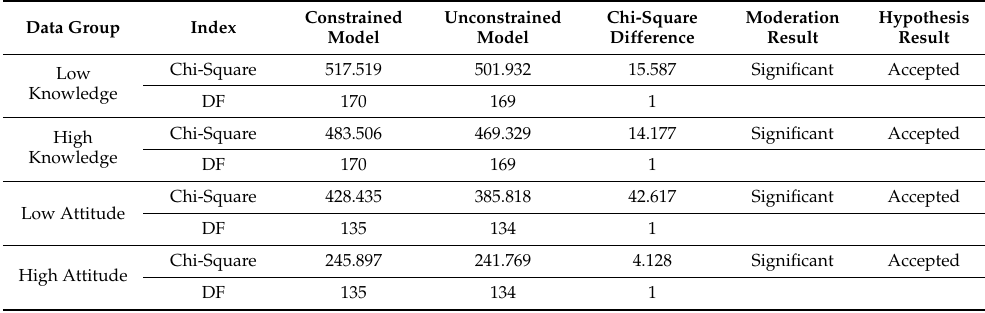
Table 6. Measure on Constrained and Unconstrained Models for Moderating Variables. Data Group Index Constrained